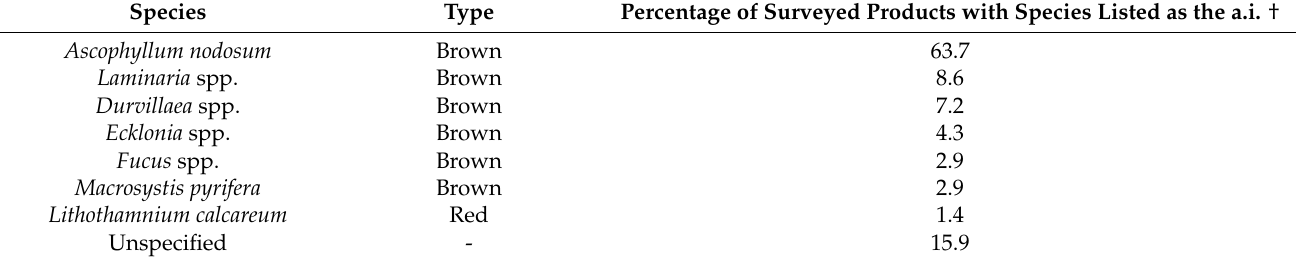
Table 1. Summary of the primary macroalgae species utilized in commercially available seaweed extract biostimulants. Sixty-nine individual products were identified and grouped by macroalgae species listed as the active ingredient. Data compiled from Khan et al. [25] ( n = 25); Sharma et al. [26] ( n = 28); and supplemented with additional products ( n = 16) that were not previously included. Species Type Percentage of Surveyed Products with Species Listed as the a.i. † Ascophyllum nodosum Brown 63.7 Laminaria spp. Brown Durvillaea spp. Brown Ecklonia spp. Fucus